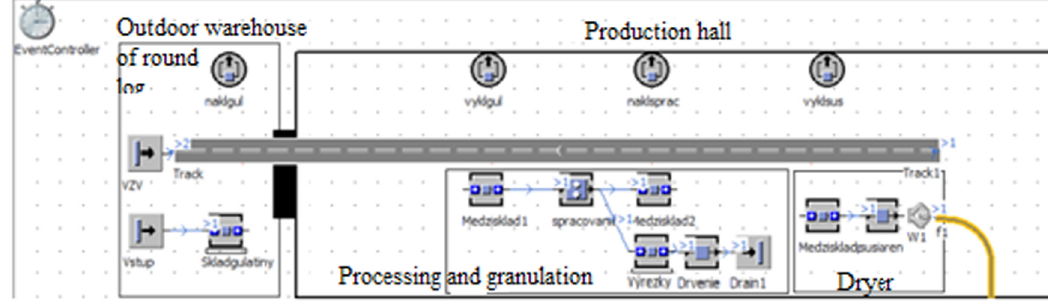
Figure 4: Production hall 1 in the simulation program. Source: authors.